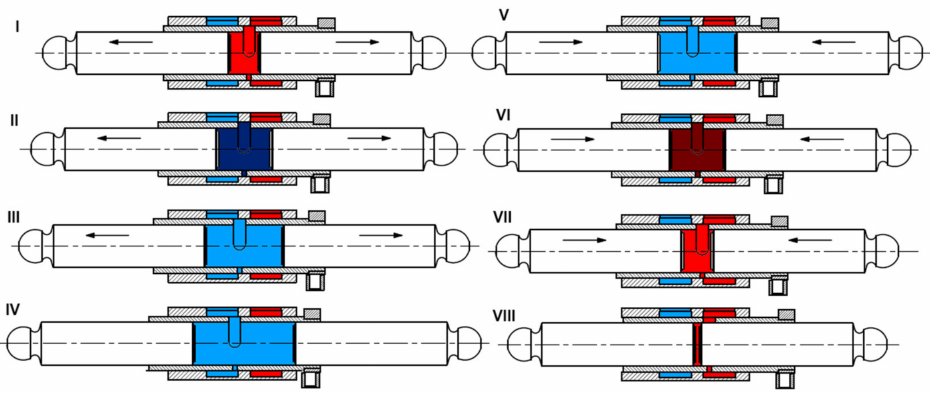
Figure 4. Cycle of the PWK pump’s working chamber volume change at decreased displacement